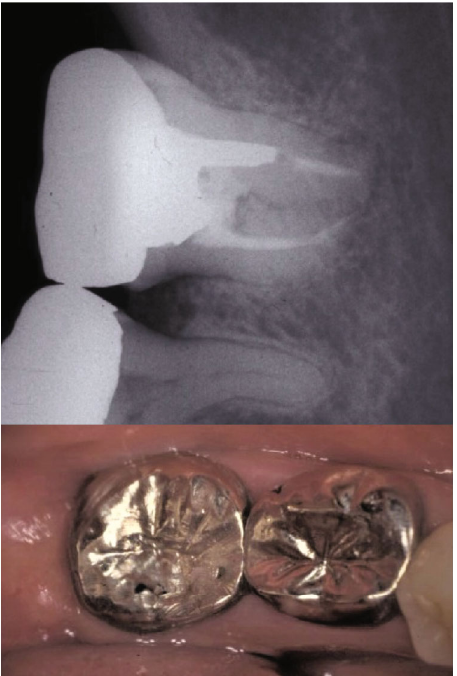
Figure 7: Ten-year follow-up after the transplantation. The size of the apical radiolucency reduced from one year after the